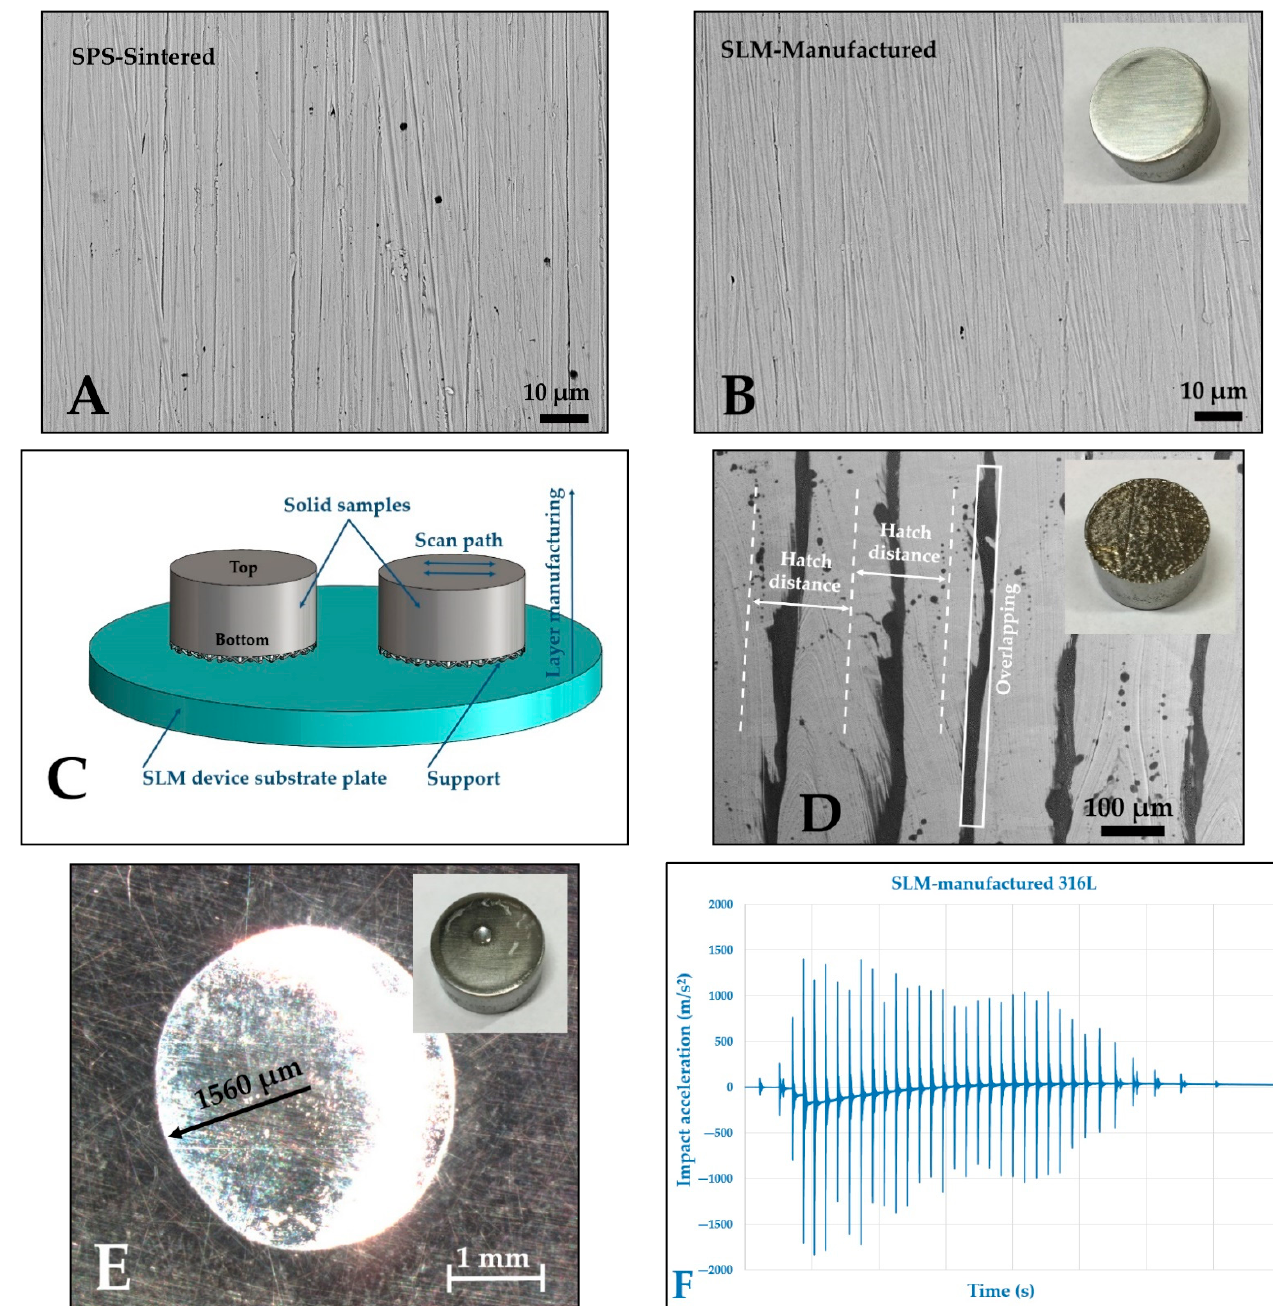
Figure 7. ( A ) SEM micrograph of SPS-sintered (before micrography, samples were polished with P800 wet sandpaper), ( B ) SEM micrograph of SLM-manufactured of 316L (after separating the support from platform/substrate, the bottom side was polished but top side remained intact), ( C ) schematic of SLM device (316L SLM-built sample had a 20 mm diameter and 10 mm height, similar to SPS-built samples), ( D ) top view of SLM-made 316L (this was the last manufactured layer of the sample, and it is possible to see the oxide layer due to overlapping and hatch distance in the path of laser scanning), ( E ) optical images of the deformation sites for 316L SLM-manufactured after impact tests, ( F ) acceleration measurement of impacts for 316L SLM-built alloy.